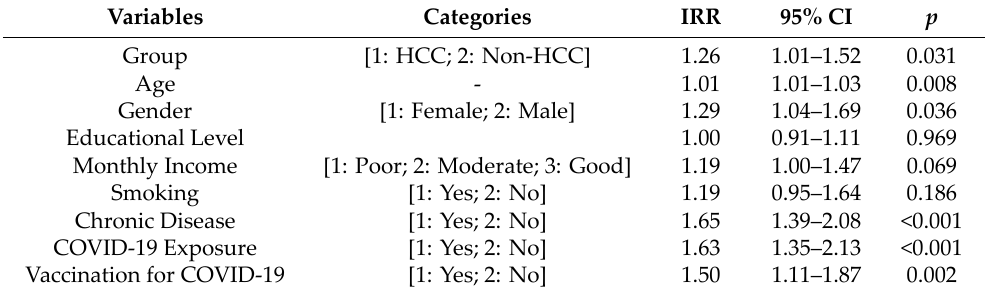
Table 6. Results of the negative binomial regression model for total scores of the DASS‑21 scale.